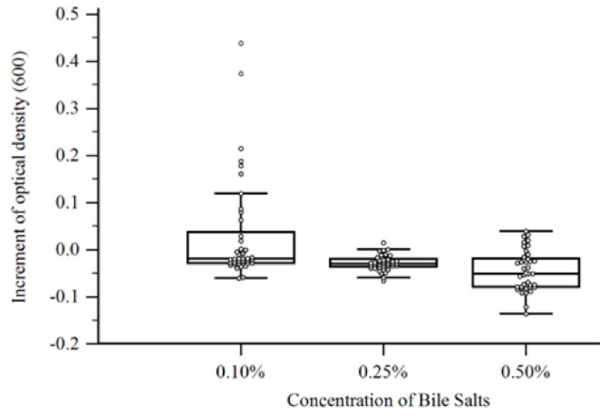
Fig. 6. Effect of bile salts on bacterial growth. The increment of optical density after 48 h of incubation for each isolate in media containing different bile salts concentrations are displayed. Box-and-whisker plots represent each bile salt concentration (0.1, 0.25 and